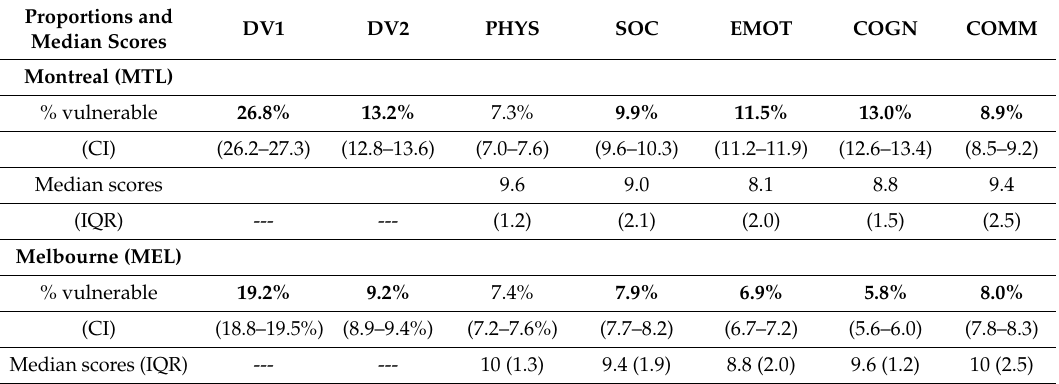
Table 4. ProportionsofdevelopmentallyvulnerablechildrenandmedianscoresinMontrealandMelbourne. Proportions and Median